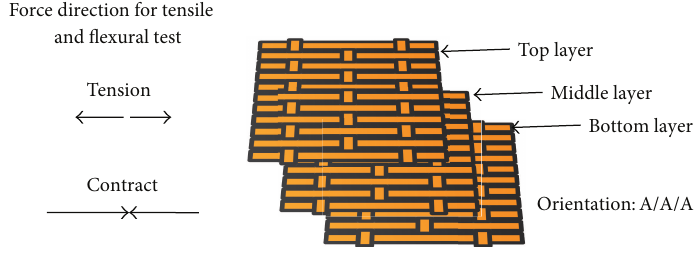
Figure 4: Sample 1: orientation A/A/A.